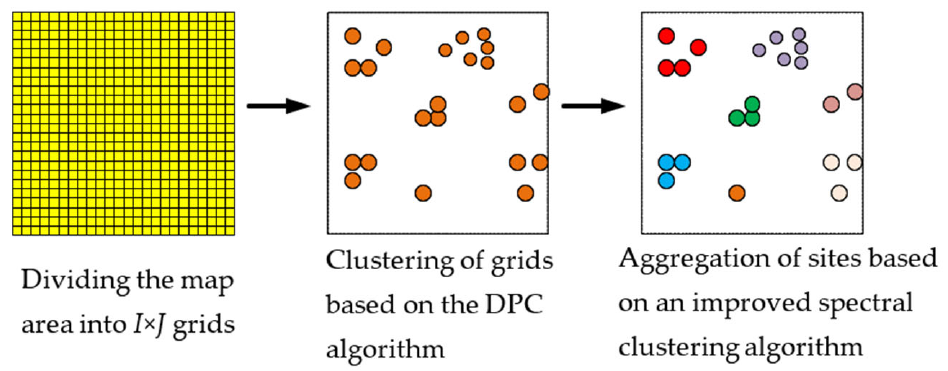
Figure 2. Two-stage clustering Figure 2. Two ‐ stage clustering algorithm.